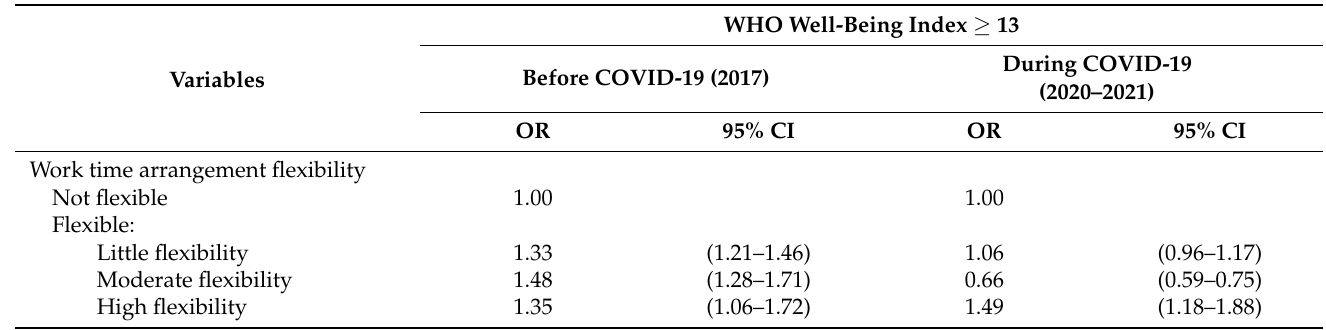
Table 2. Results of factors associated with a high well-being index.